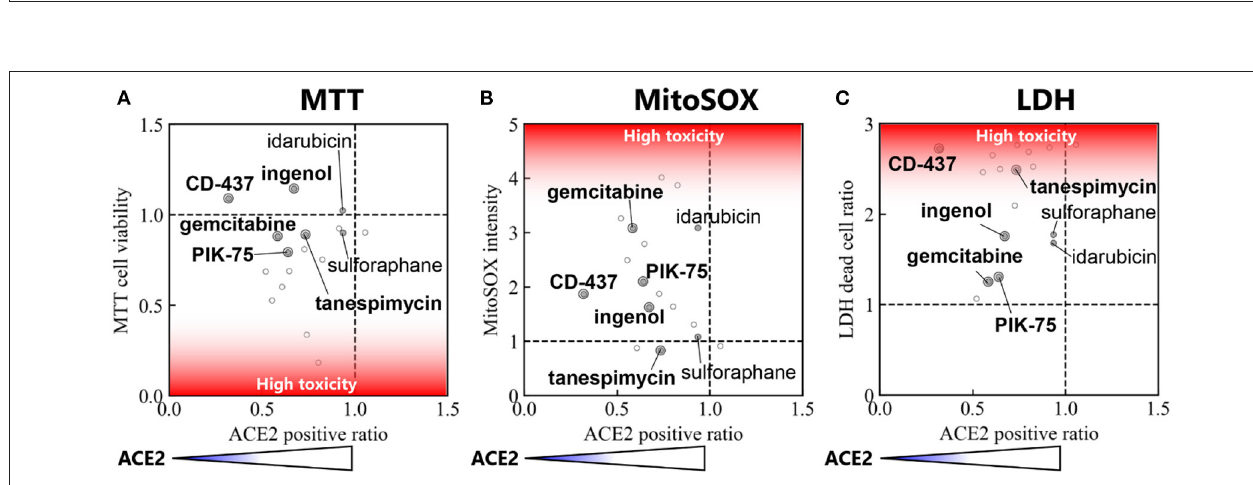
FIGURE 5 | Correlation between ACE2 positive ratio vs. cell toxicity. Correlation between ACE2 positive ratio and (A) cell viability measured by MTT assay, (B) MitoSOX Assay, and (C) LDH assay. The locations of the top 7 small molecules with reduced cytotoxicity in Table 2 are